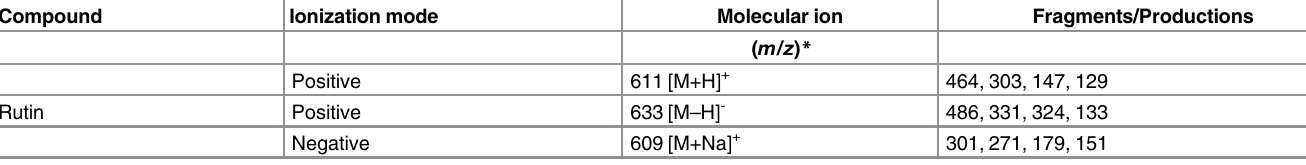
Table 1. Ion transitions under MRM mode employed to monitor for rutin in the sample.